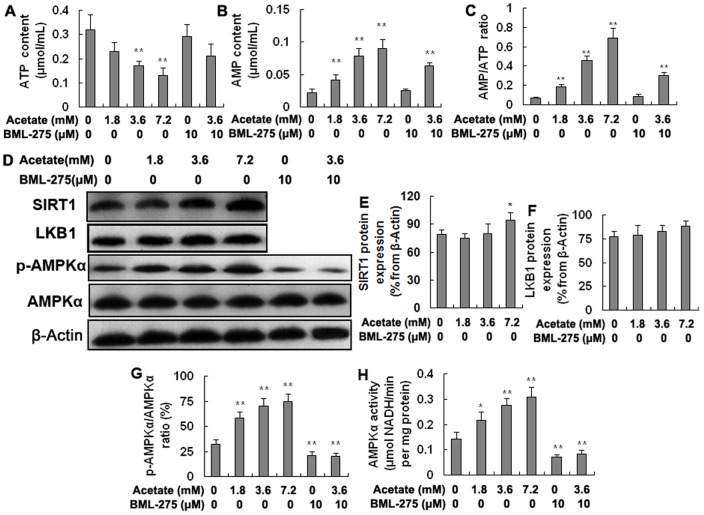
Acetic acid activates the AMPKα signaling pathway.Hepatocytes were treated with acetate and BML-275 and were divided into a control group (0 mM acetate), a low-dose acetate treatment group (1.8 mM acetate), a medium-dose acetate treatment group (3.6 mM acetate), a high-dose acetate treatment group (7.2 mM acetate), a BML-275 group (10 μM BML-275), and a BML-275+acetate group (10 μM BML-275+3.6 mM acetate). Acetate (sodium acetate) was used in the form of neutralized acetic acid to avoid changing the pH of the medium. A: AMP content. B: ATP content. C: AMP/ATP ratio. D: Western blotting results for SIRT1, LKB1, p-AMPKα, and AMPKα. E: The protein levels of SIRT1. F: The protein levels of LKB1. G: The phosphorylation level of AMPKα (p-AMPKα/AMPKα). H: AMPKα activity. * p<0.05, ** p<0.01 versus the control group.